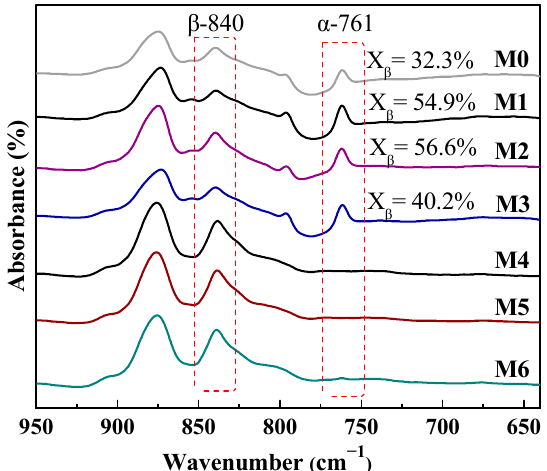
Figure 8. FITR spectra of PVDF composited membranes with oriented or unoriented mCNTs grafting single and diblock chains and membranes with oriented or unoriented mCNTs.